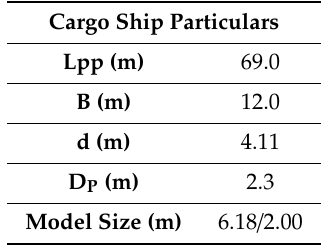
Table 4. Principal dimensions of ship and models.